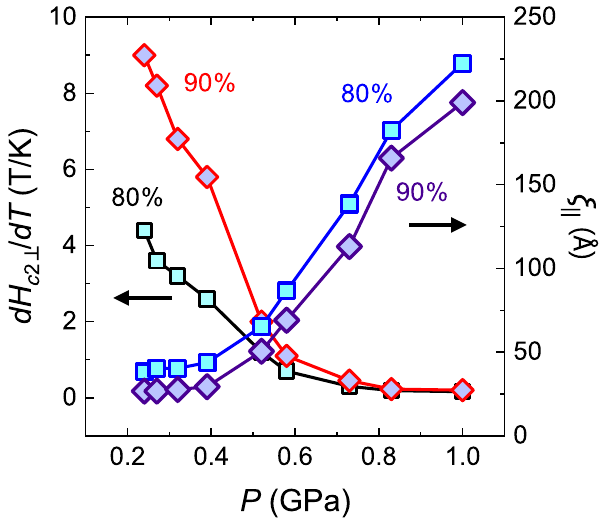
FIG. 4. Upper critical field and superconducting coherence length. The in-plane Ginzburg-Landau coherence length ξ k calculated from the slope of the upper critical field, dH =dT near T H c 2 ⊥ c , where the c 2 ⊥ is determined from the line at ρ ð T; H Þ = ρ n ð T Þ ¼ 0 . 8 , 0.9 (80% and 90% of the normal-state resistivity) in Fig. 3. The squares and diamonds are the values determined for ρ ð T; H Þ = ρ n ð T Þ ¼ 0 . 8 and 0.9,